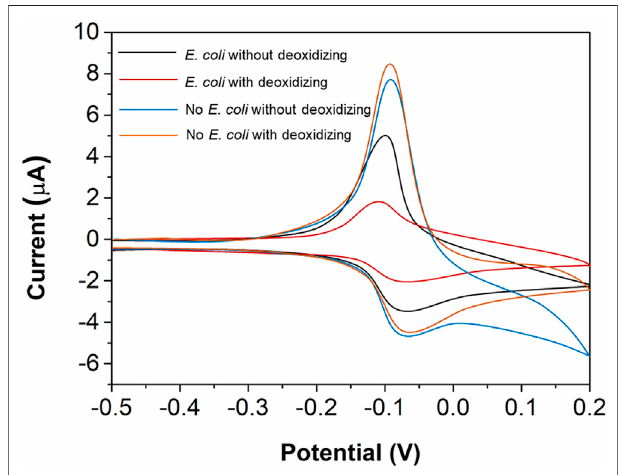
FIGURE 3 | Effect of dissolved oxygen on CV signal of MB in the presence of E. coli ATCC25922.